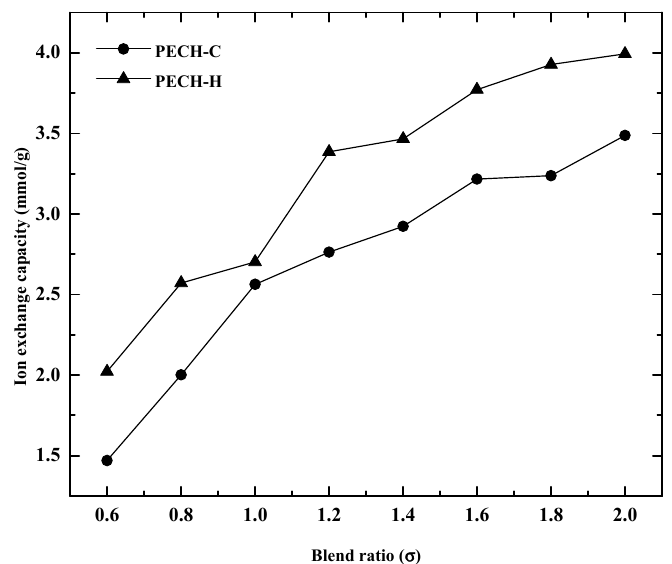
Figure 6. Impact of blend ratio on ion exchange capacity for the PECH membranes at EDR of 2.